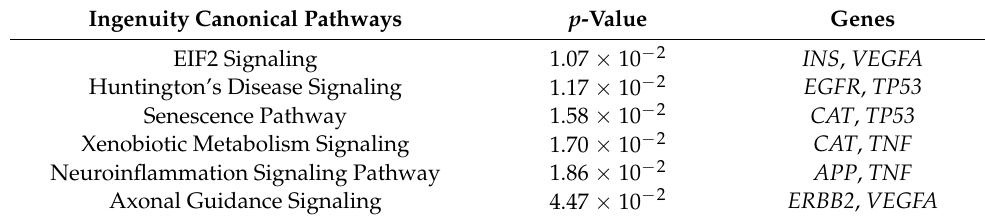
Table A3. Ingenuity Pathway Analysis showing significant (Fisher’s Exact Test p < 0.05) related to the 16 genes found using Coremine Medical as a text search engine. These significant pathways are associated with p -values >